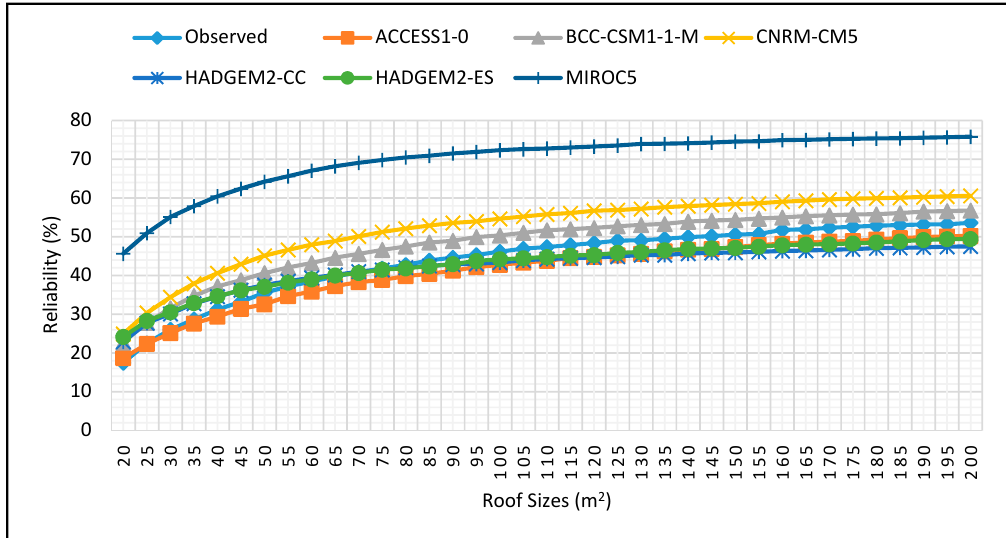
Figure 20. Reliability projections for JJA season for 0.5 m 3 tank size for 2060–2090 period. Water 2018 , 10 , 71